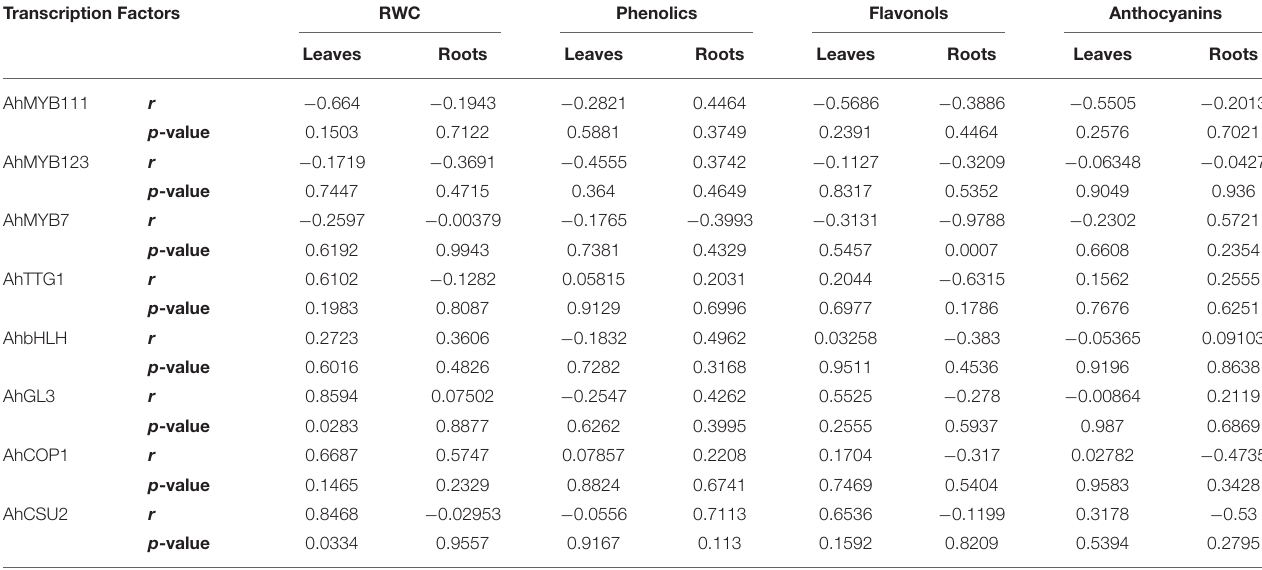
TABLE 4 | Correlational analysis between expression of TFs related to the biosynthesis of flavonoids and the accumulation of phenolics, flavonols, and anthocyanins in peanuts under water deficit conditions. Transcription